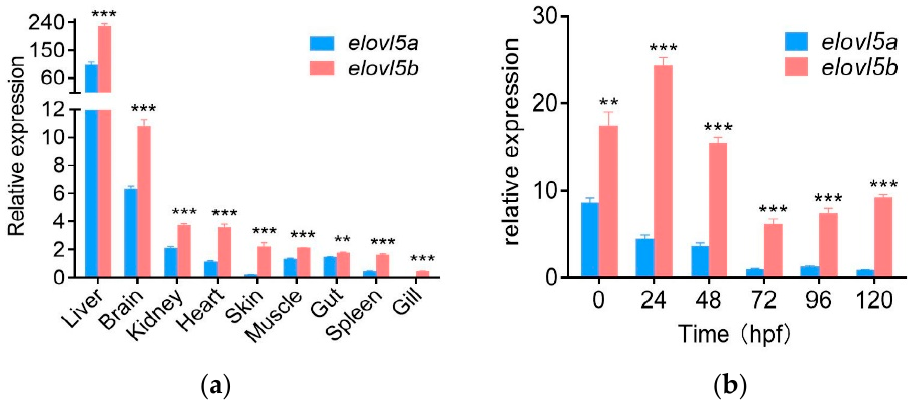
Figure 3. The expression levels of elovl5a and elovl5b in mature common carp tissues. ( a ) The expression levels across nine tissues. ( b ) The levels across six developmental stages from 0 to 120 h post-fertilization (hpf). The results are shown as the mean ± standard deviation (SD). Two asterisks refer to the p value < 0.01 and three asterisks refer to the p value < 0.001.